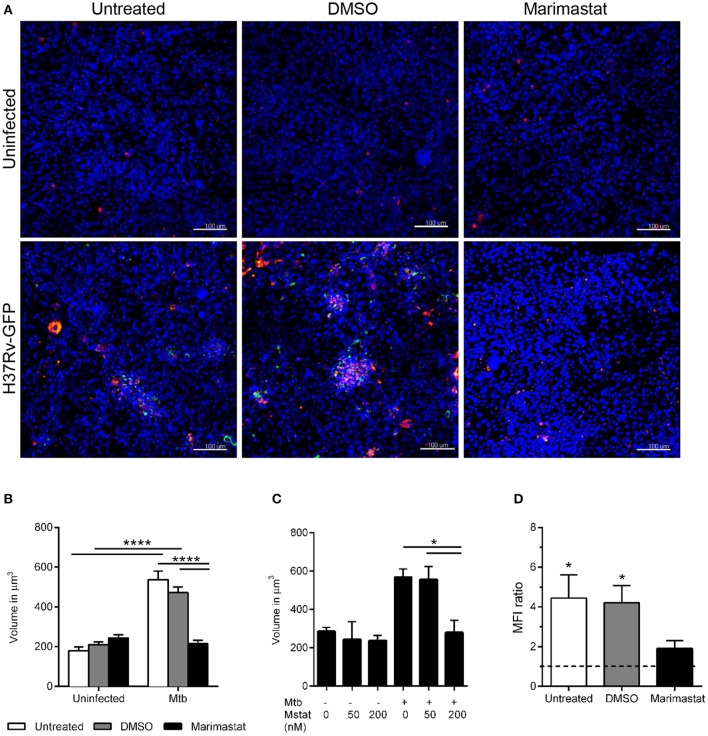
Effect of marimastat on early granuloma formation in Mtb-infected lung tissue models. (A) Tissue models (nuclei stained with DAPI, blue) were left untreated or incubated with DMSO or marimastat before implantation with PKH26-labeled monocytes (red) and macrophages, uninfected or infected with GFP-expressing (green) H37Rv. The tissues were fixed at day 7 and subjected to DAPI-staining followed by confocal microscopy. Images show merged confocal images of randomly selected fields (uninfected models) or bacteria-harboring fields selected in the green channel (H37Rv-GFP-infected models) with treatments as indicated. (B) Z-stacks were obtained in the red channel and the volume of the cells/clusters was determined in uninfected and infected samples with or without 200 nM marimastat (n = 13). (C) Two different concentrations of marimastat (Mstat), 50 and 200 nM were tested (n = 3). (D) Regions of interest (ROIs) with (ROIbact) and without bacteria (ROIcon) were selected in the green channel and the MFI in the red channel was determined. Recruitment of monocytes/macrophages to the site of infection is expressed as ratio of MFI (ROIbact)/MFI (ROIcon, n = 6). Data are expressed as means + SEM. Statistical analyses were carried out using 2-way ANOVA with Sidak's multiple comparisons test for comparisons within and between groups (B), 1-way ANOVA with Tukey's multiple comparisons test within the infected group (C) and Wilcoxon signed rank test to compare MFI ratio (D). Scale bars are 100 μm. *p ≤ 0.05, ****p ≤ 0.0001.